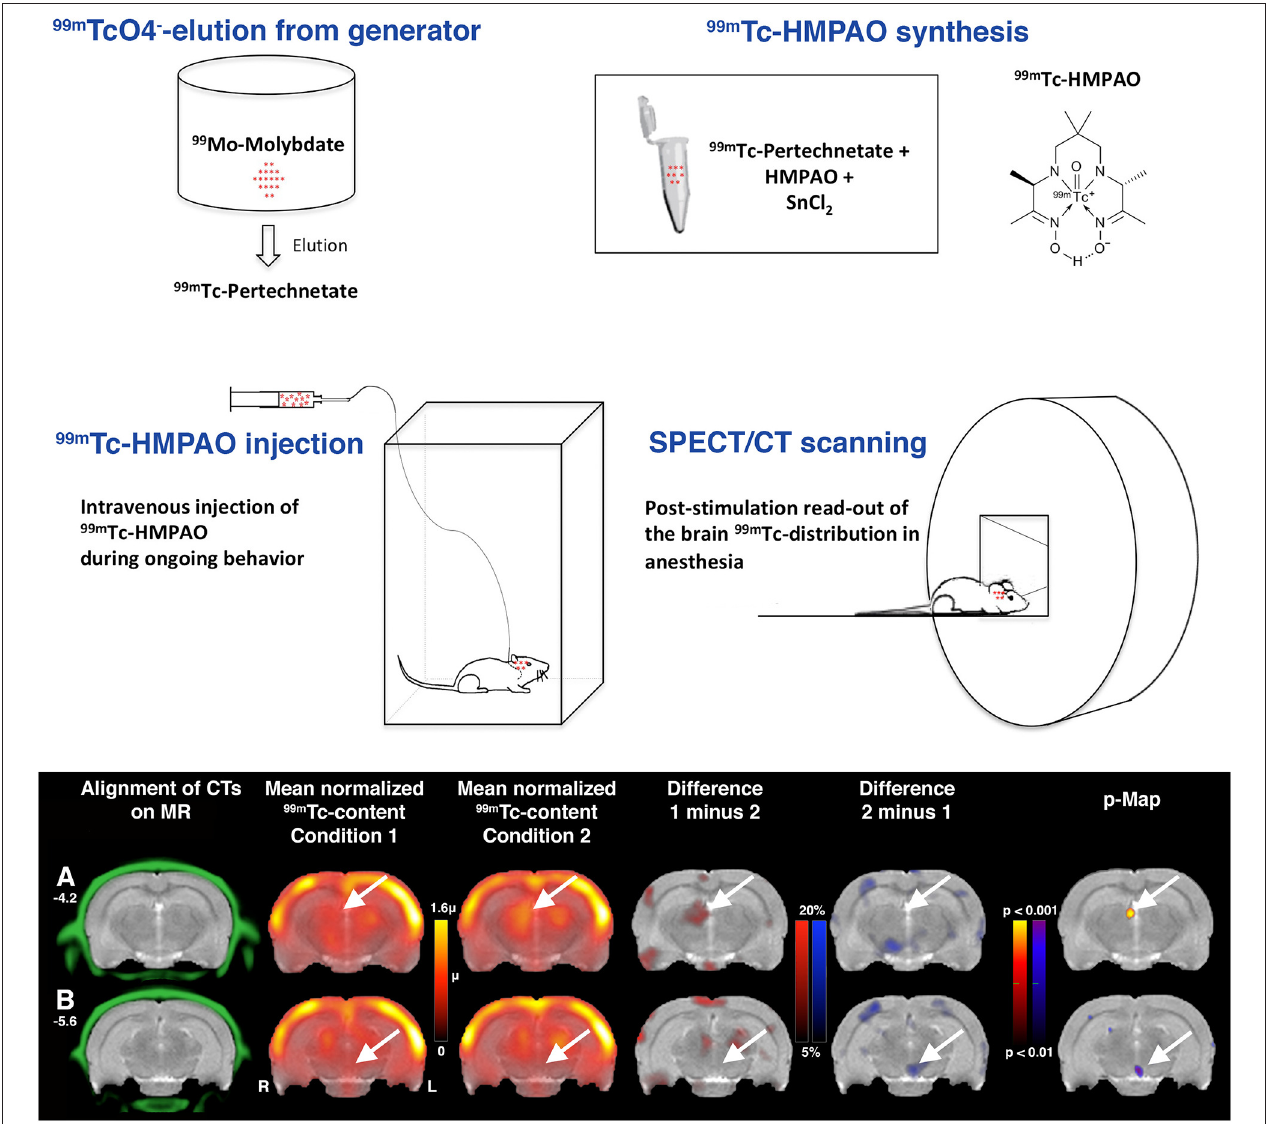
FIGURE 5 | Workflow in functional neuroimaging using 99m Tc-HMPAO SPECT. After elution of 99m Tc-pertechnetate from the 99m Tc generator, 99m Tc-HMPAO can be synthesized on-site in the small-animal SPECT lab. Rodents are intravenously injected with the tracer during ongoing behavior. For SPECT scanning of the distribution of the trapped tracer, the animals are anesthetized. Data analysis starts with aligning of the SPECT data sets to reference MRs or atlases by using the landmarks of the co-registered CT. Here, previously unpublished images from data of a subgroup of rats from the study of innate fear behavior in Vincenz et al. [70] are shown to illustrate the data analysis. Sections at two different Bregma levels are shown ( A Bregma − 4.2; B Bregma − 5.6). The color scale on the left is in units of the global mean intensity. Arrows point to the habenula and interpeduncular nucleus where significant increases or decreases, resp., in flow were found.